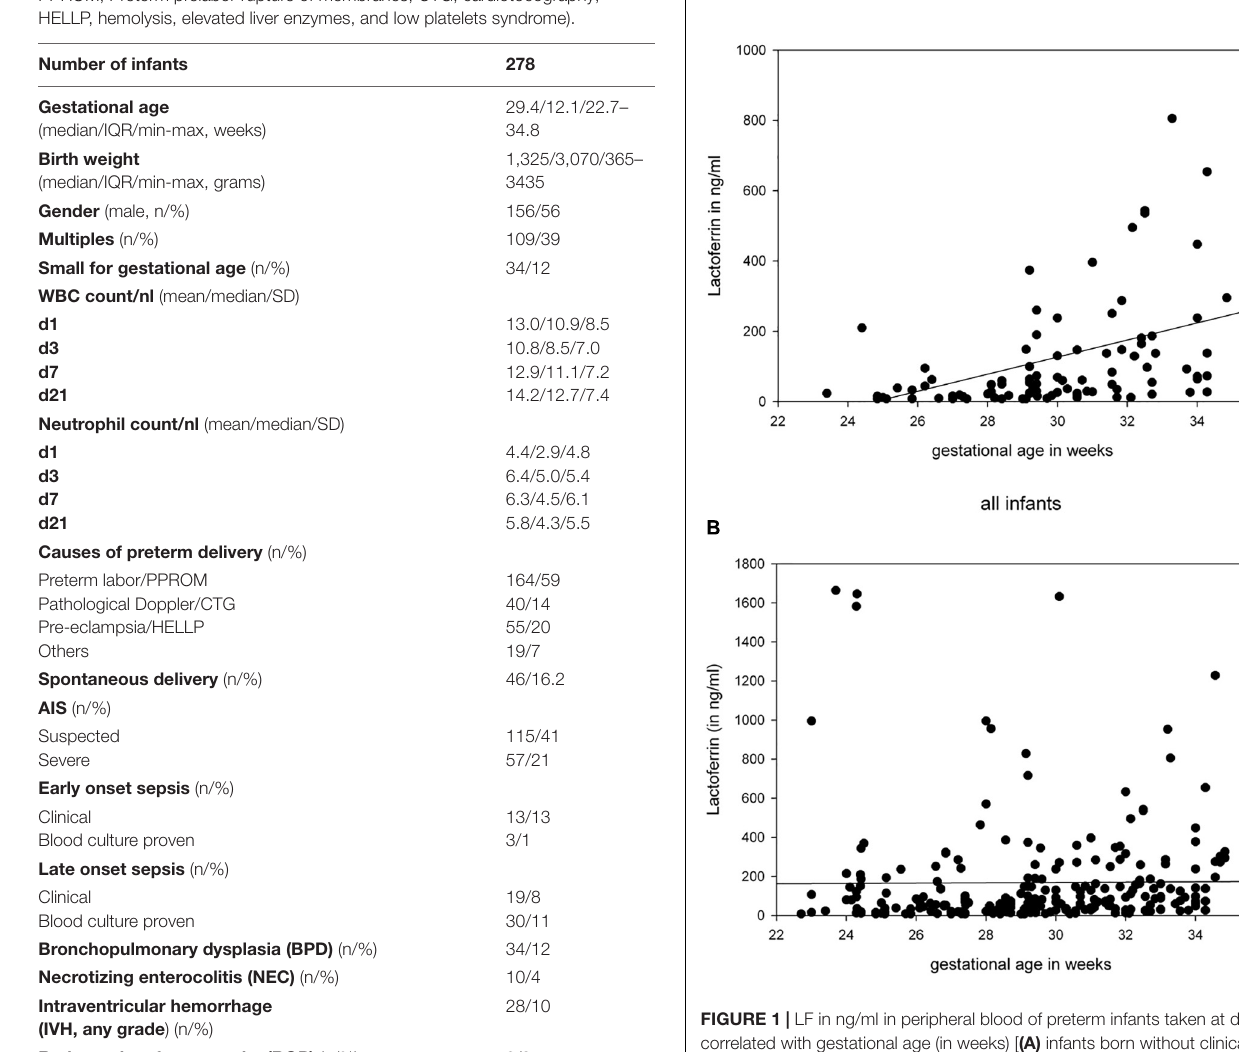
TABLE 1 | Clinical characteristics of study cohort (WBC, white blood cell; PPROM, Preterm prelabor rupture of membranes; CTG, cardiotocography; HELLP, hemolysis, elevated liver enzymes, and low platelets syndrome).